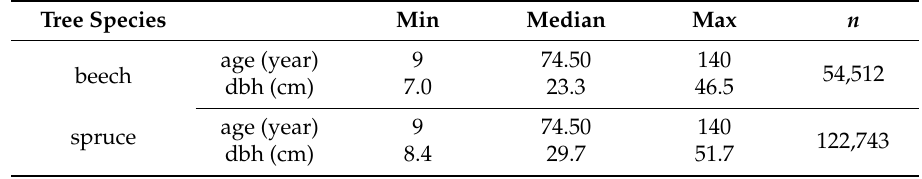
Table A3. Characteristics of diameter-dataset used for fitting Equation (14).